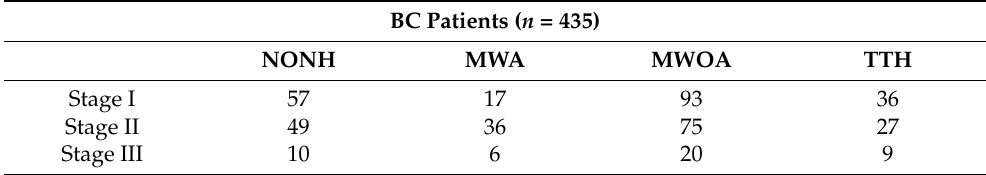
Table 5. Headache diagnosis in relation to clinical